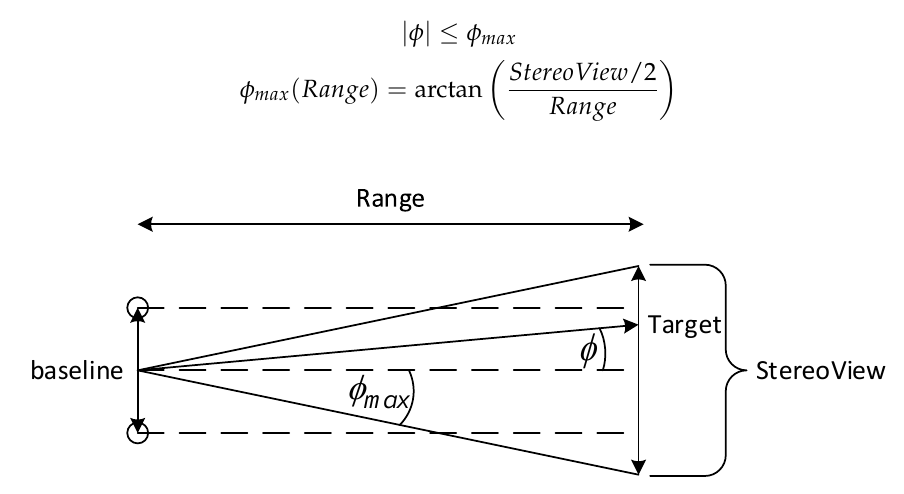
Figure 5. A two dimensional geometry of two aligned cameras with their horizontal angle of view